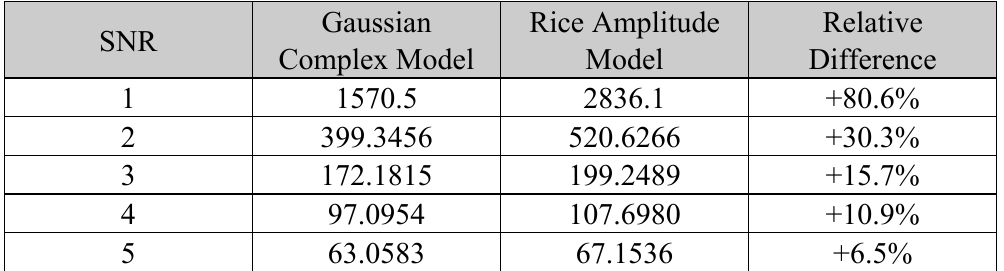
Table 1 . CRLB values in case of different SNRs for the proposed Gaussian Complex Model and for the Rice Amplitude Model.